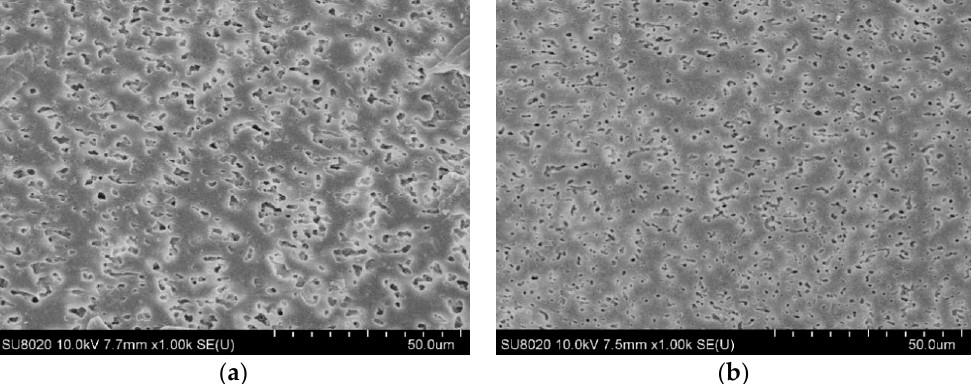
Figure 2. SEM images of ( a ) isotactic polypropylene (iPP)/styrene–butadiene–styrene block copolymer (SEBS), and ( b ) cPP- g -MAH/iPP/SEBS.